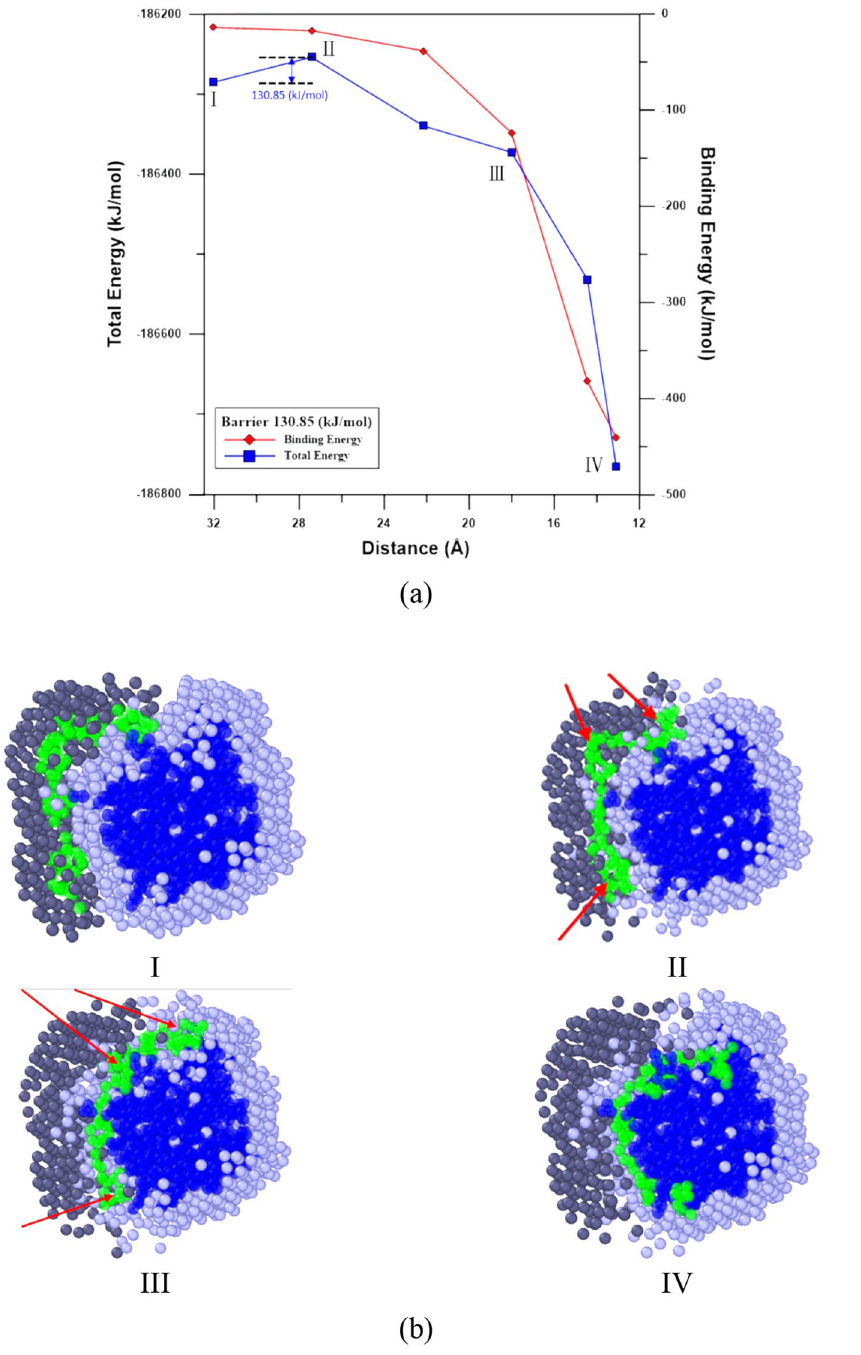
Figure 6. ( a ) Total energy and binding energy profiles with the center-of-mass distance between Apt EpA and EpCAM for CG_Case1 during the NEB process. ( b ) The slice plane views of water bead distribution within 10 Å from Apt EpA. Morphologies I to IV correspond to structures as labelled in the NEB profile. The Apt EpA , EpCAM, water beads surrounding Apt EpA and water beads surrounding EpCAM are marked in green, dark blue, dark gray, and light gray,